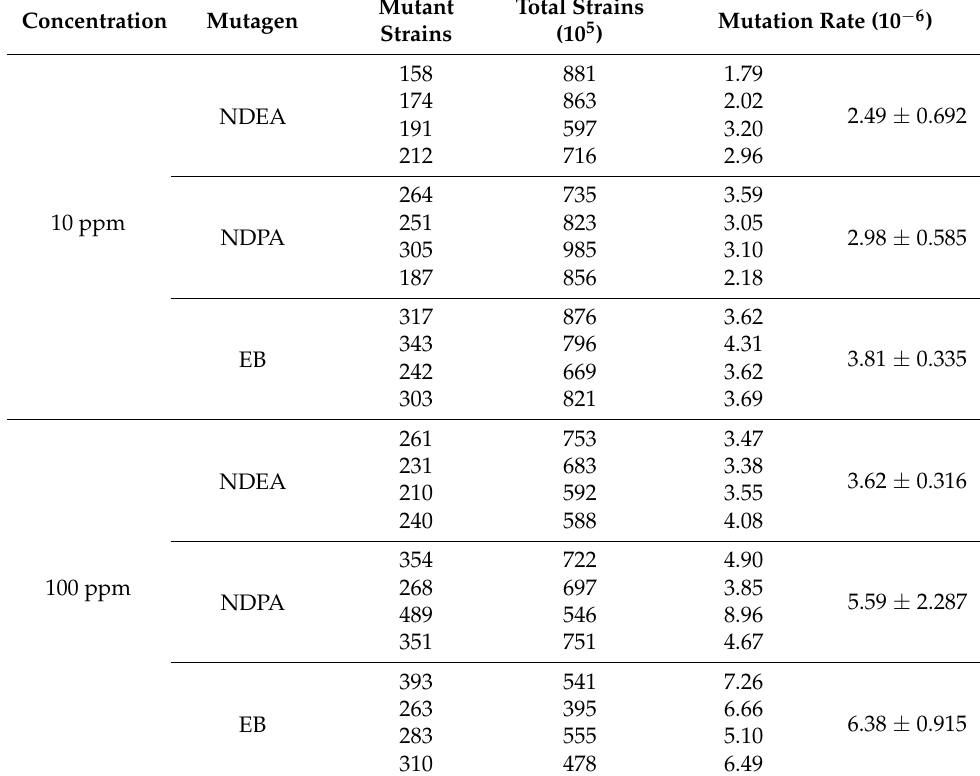
Table 7. Mutation rate of rpsL induced by mutagens in the RCA